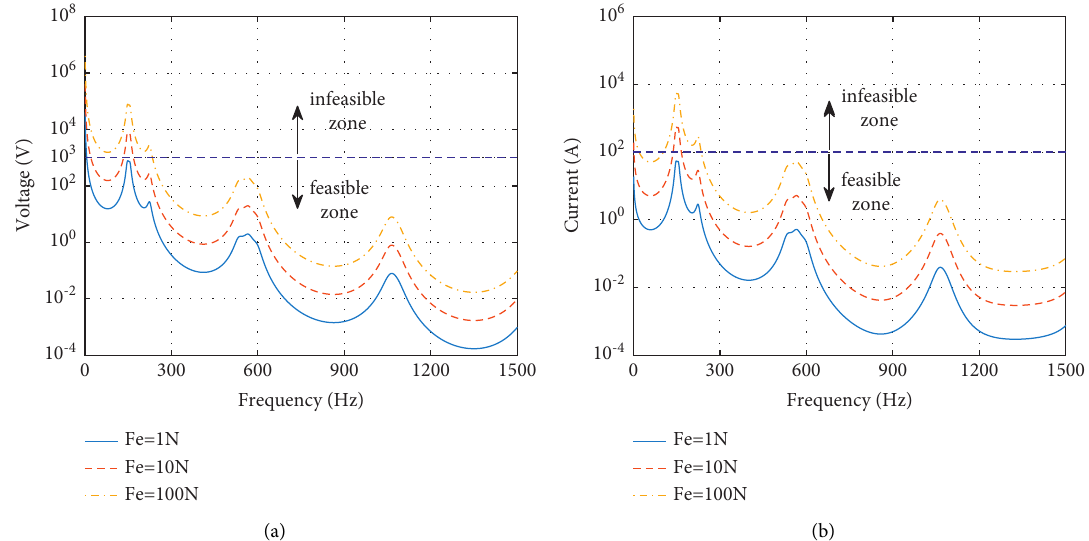
Figure 16: Voltages and currents of PSPS with different excitation forces. (a) Required voltages of the piezoelectric stacks under active control. (b) Required currents of the piezoelectric stacks under active